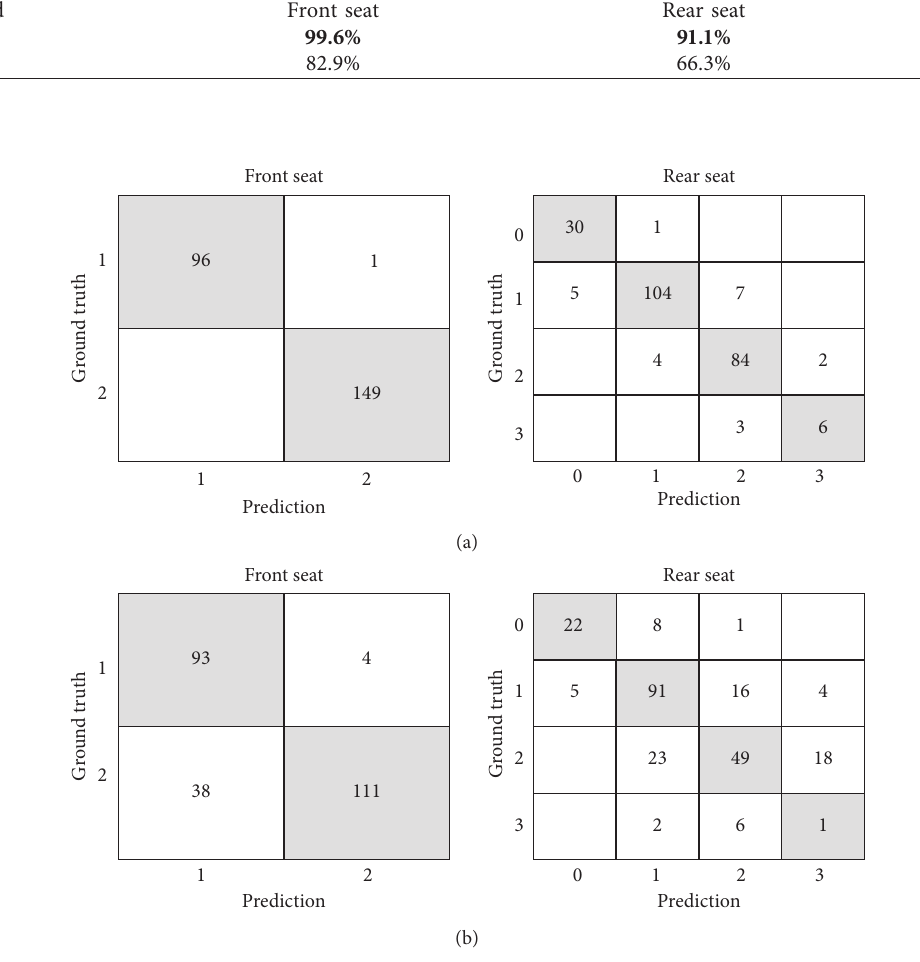
Figure 6: Confusion matrices for tested models. (a) Occupant labeling result. (b) Human labeling